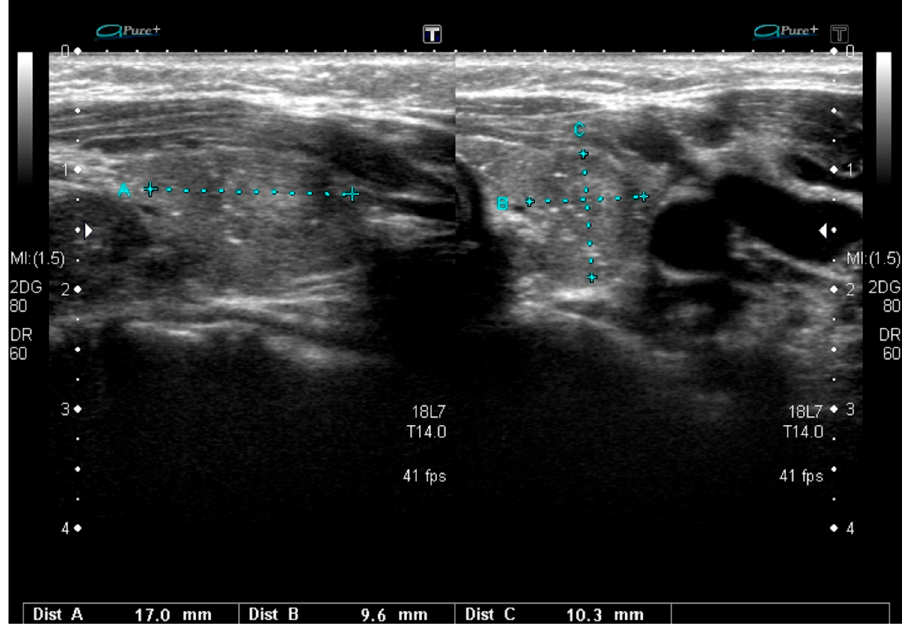
Figure 2. Sonographic pattern typical for the RET/PTC3 -dependent diffuse sclerosing variant of PTC with a poorly defined area with heterogeneous parenchyma and scattered microcalcifications.